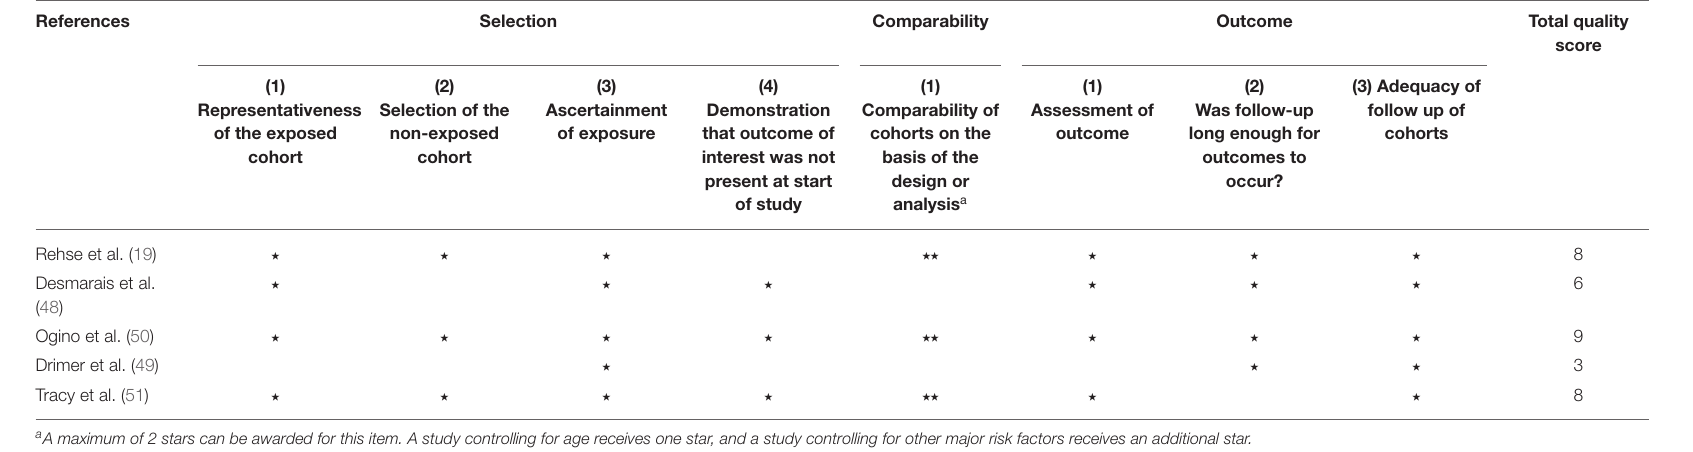
TABLE 4 | Quality assessment of cohort studies